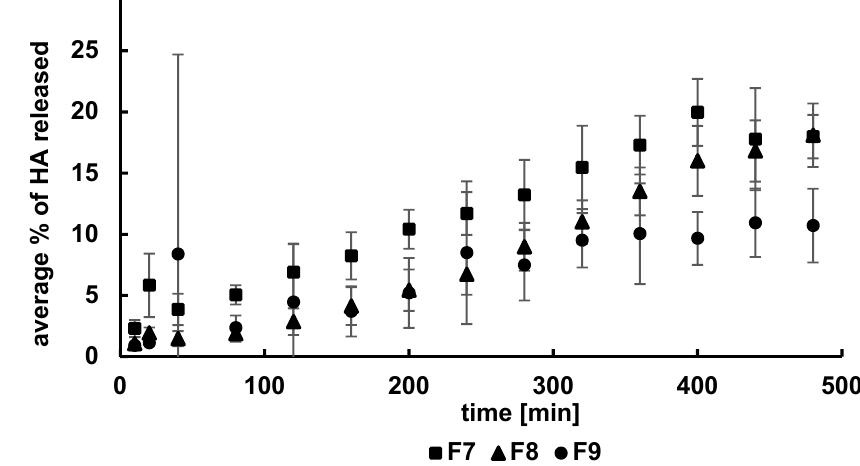
Figure 3. The release profiles of HA from formulations F7–F9.